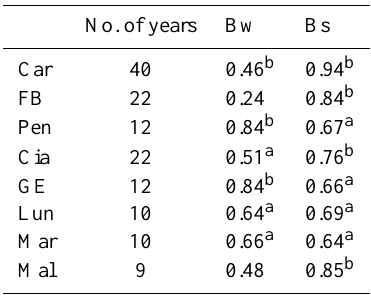
Table 4. Correlation coefficients of B a versus B w and B s . No. of